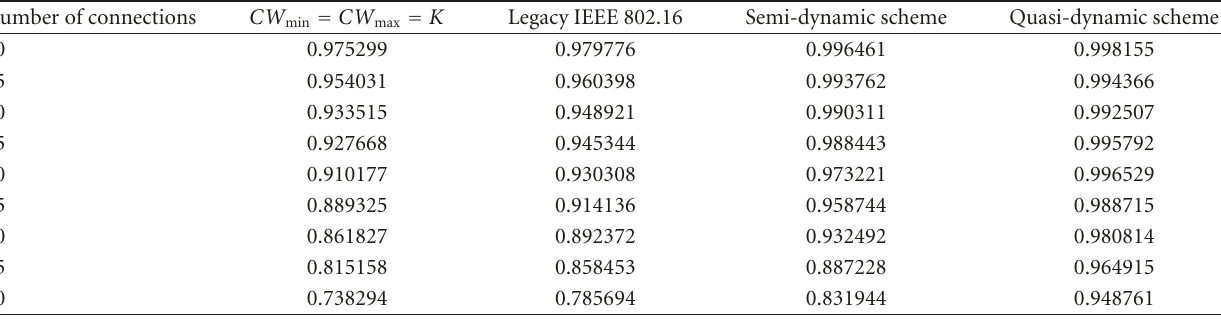
Table 3: Fairness index versus number of connections.